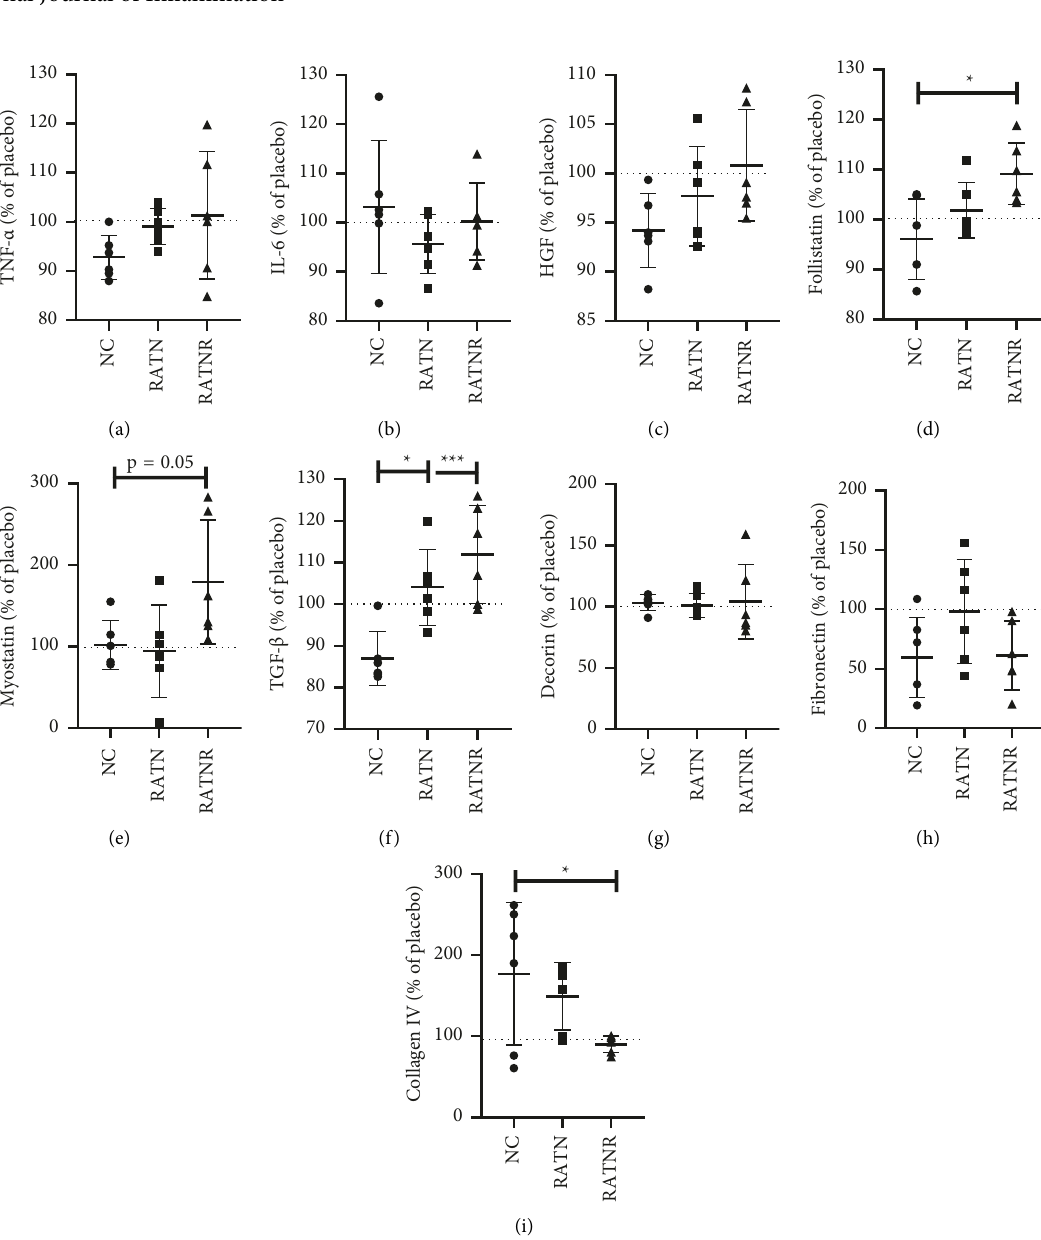
Figure 9: Cellular responses after treatment with BMP-7 expressed as percentage of response in placebo condition, as assessed in triple culture supernatant of a fibroblast, myoblast, and M1 macrophage mixed culture exposed to serum of healthy (NC), RA treatment na¨ıve (RATN), and RA treatment-nonresponding (RATNR) patients. (a) TNF- α ; (b) IL-6; (c) HGF; (d) follistatin; (e) myostatin; (f) TGF β ; (g) decorin; (h) fibronectin; (i) collagen IV. Statistical analysis: one-way ANOVA (parametric: a–e, g–i) or Kruskal–Wallis test (nonparametric: f). ∗ � p < 0 . 05; ∗∗ � p < 0 . 01; ∗∗∗ � p < 0 . 001. n � 6 per group. Data represented as mean ± SD. TNF- α � tumour necrosis factor- α ; IL � interleukin; HGF � hepatocyte growth factor; TGF β � transforming growth factor- β ; BMP-7 � bone morphogenetic protein